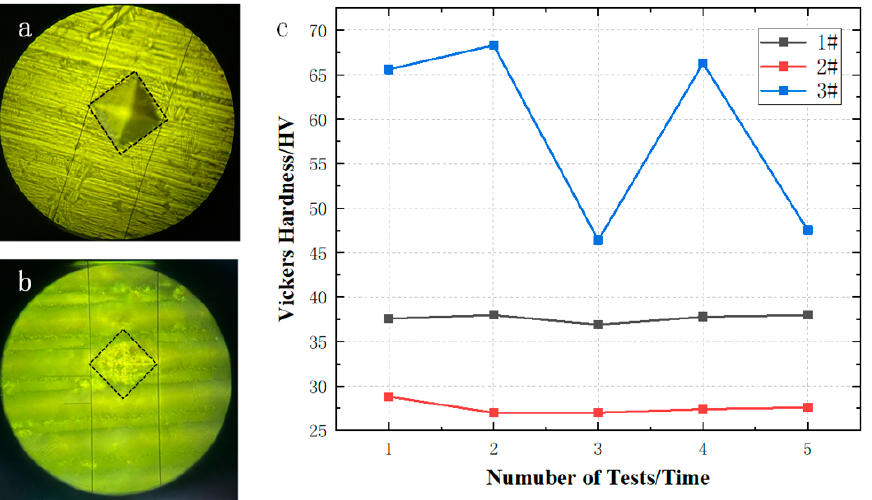
Figure 6. Microhardness analysis. ( a , b ) Optical photographs of hardness tests; ( c ) folding statistical graph of Vickers hardness for each specimen.